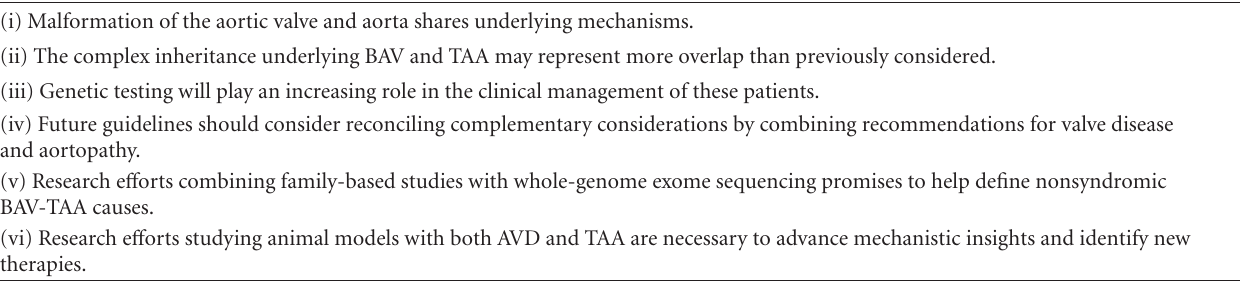
Table 1: Summary of concepts and future